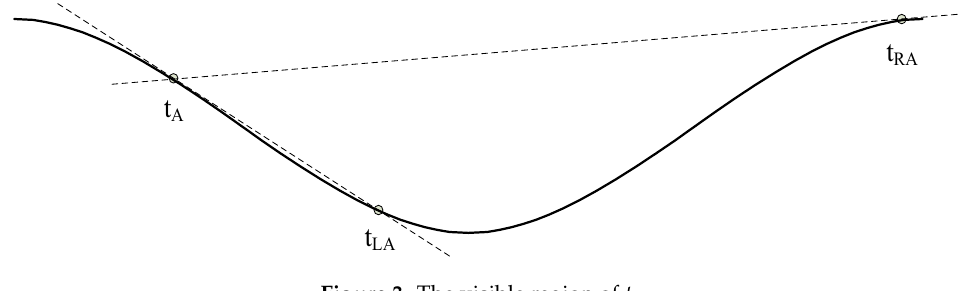
Figure 3. The visible region of